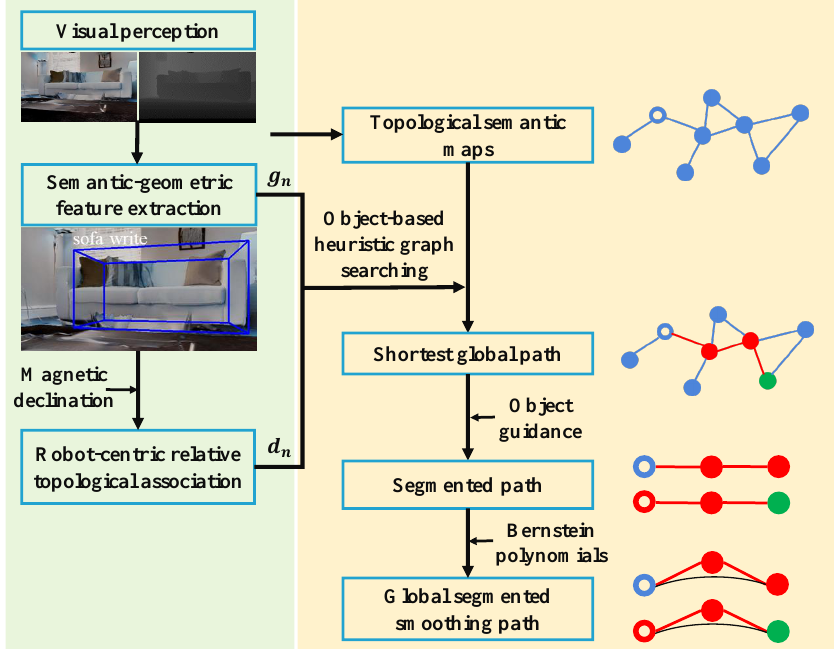
Figure 2. The block diagram outlines the specific modules in the proposed object-level topological path planning system and the connections between